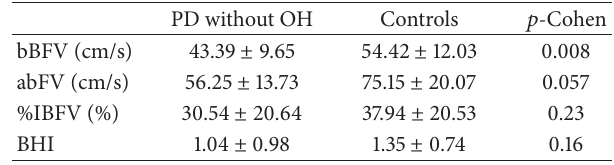
Table 3: Cerebral hemodynamic data for PD patients and controls. PD